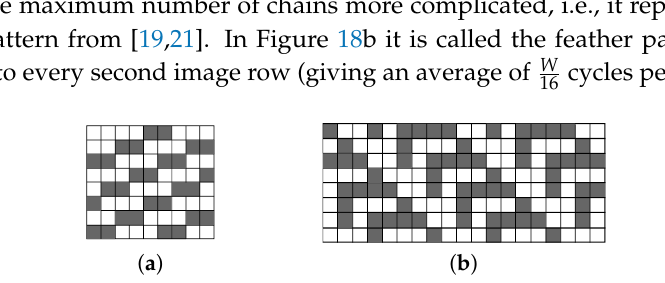
Figure 18. Image patterns that create the worst case average overhead for ( a ) [6,19,21] and for ( b )